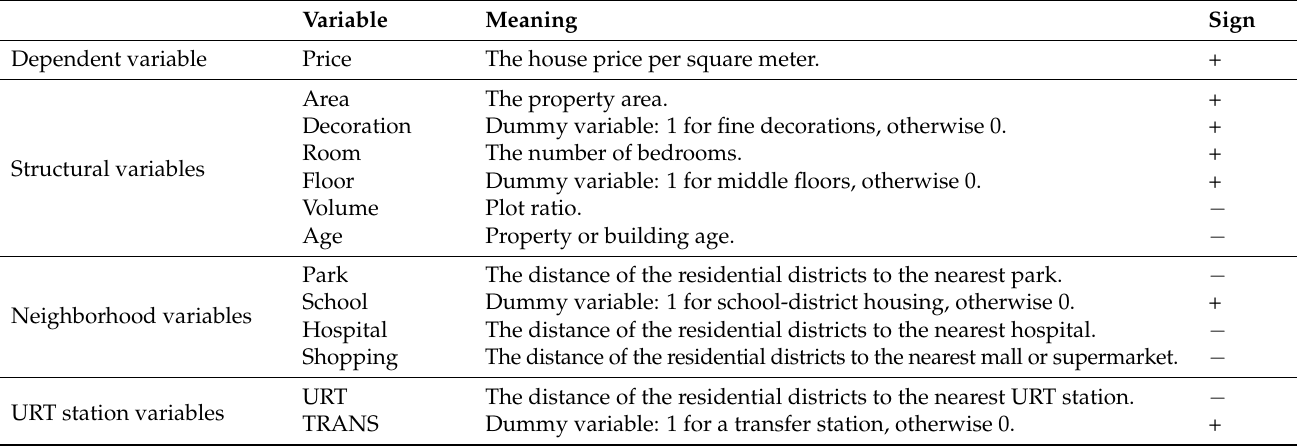
Table 1. Various proxy